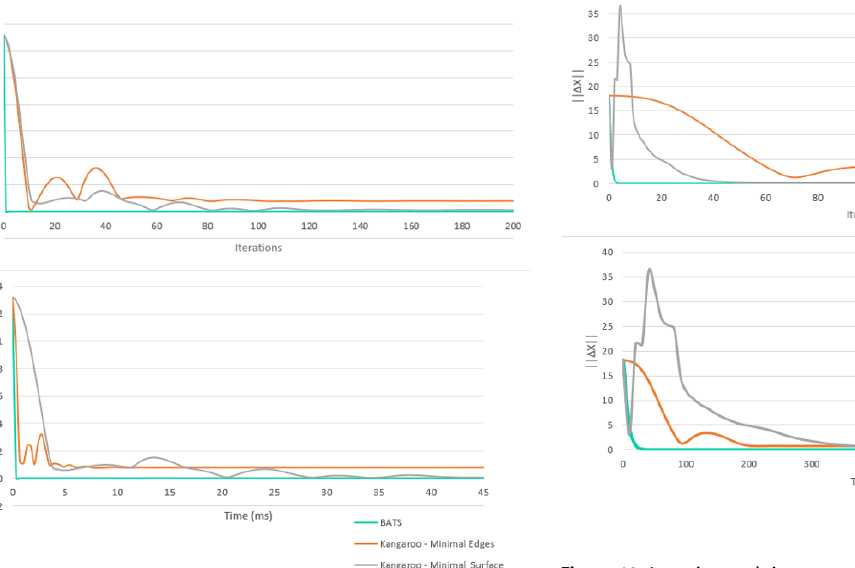
Figure 12: Iteration and time comparison for 10x10 grid